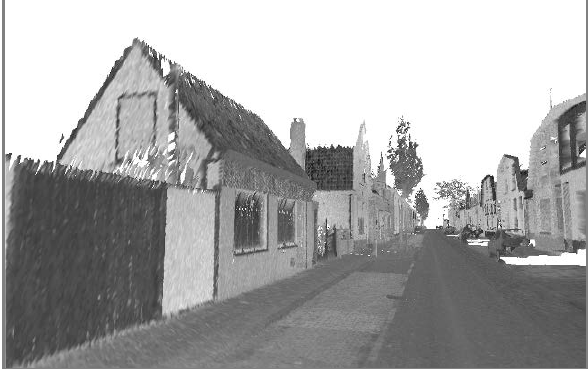
Figure 3. A triangle mesh generated from a LiDAR point cloud